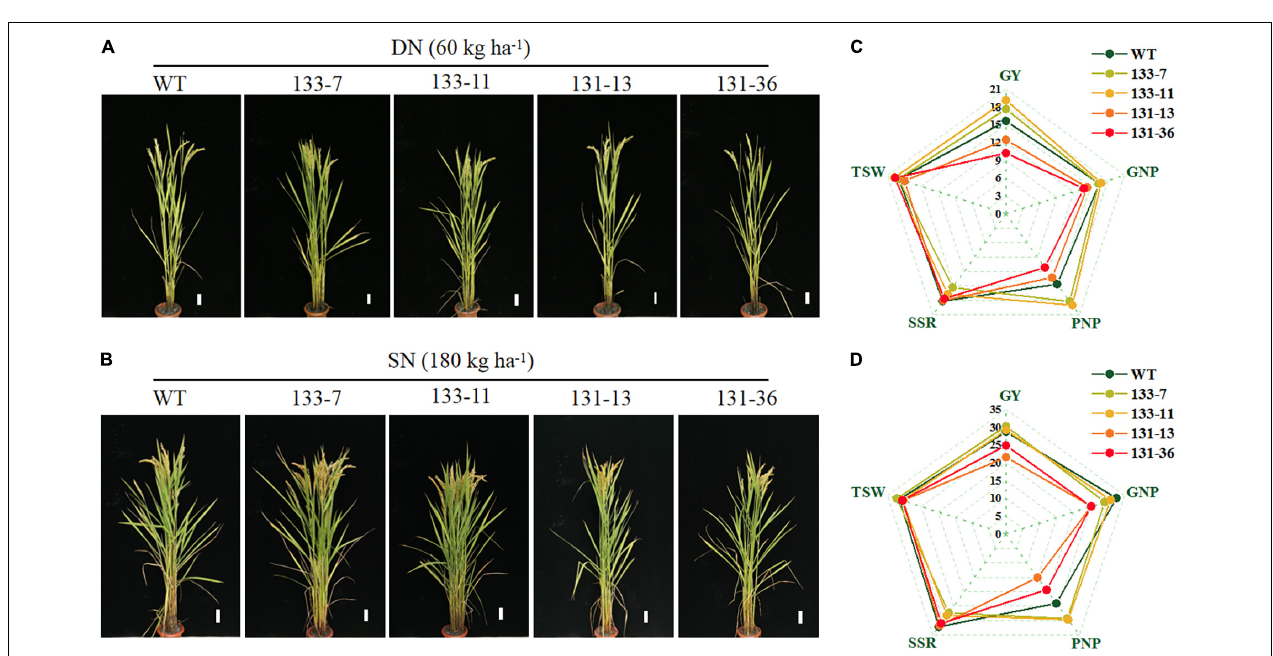
FIGURE 3 | Relative expression of candidate genes. qRT-PCR verification of the transcript levels of candidate genes under low and high N conditions.